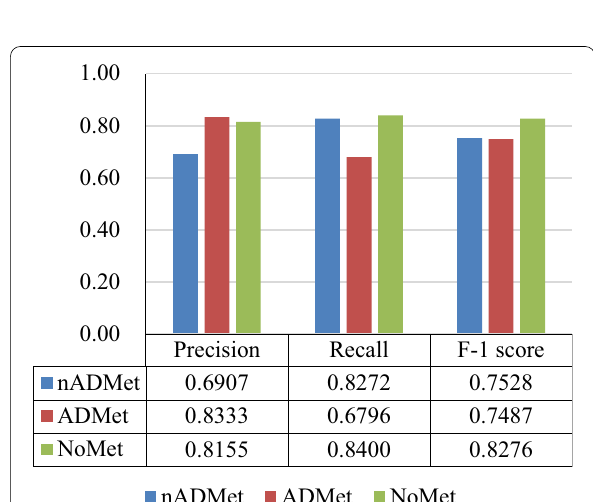
Fig. 7 Confusion matrix obtained by Classifer-inRAC on classifying the testing samples in D3